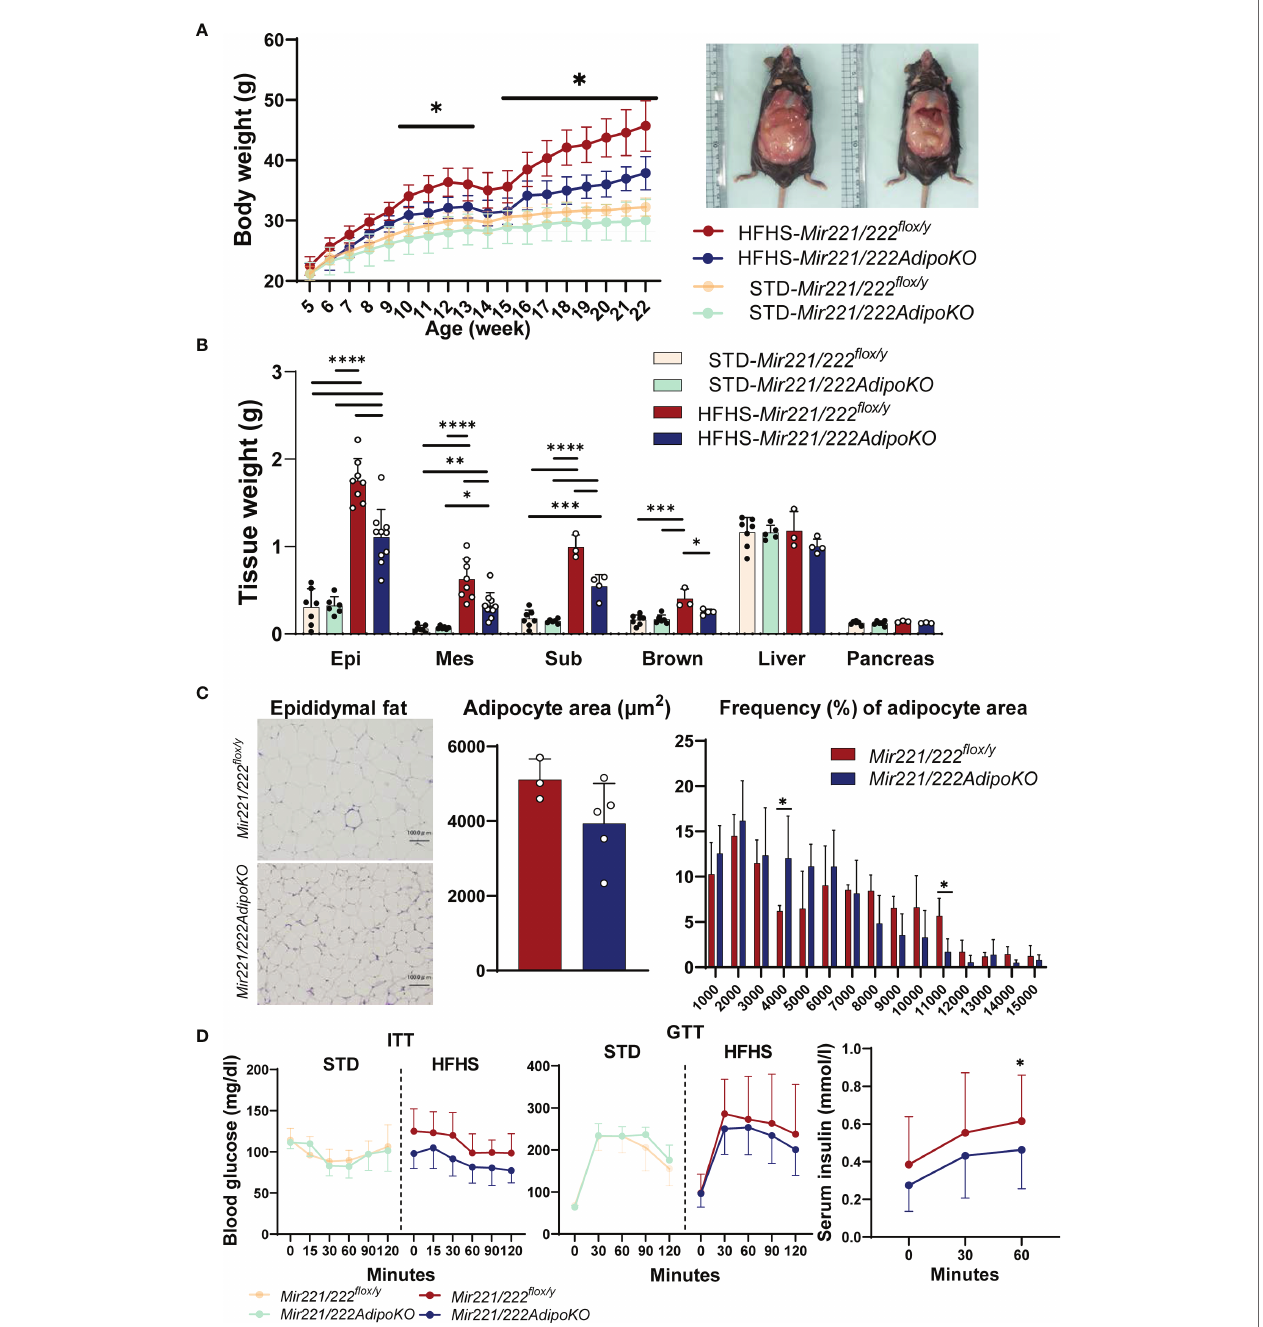
FIGURE 1 | The metabolic phenotypes of Mir221/222 fl ox/y and Mir221/222AdipoKO male mice fed with high fat high sucrose (HFHS) or standard (STD) chow. (A) Body weight of Mir221/222 fl ox/y and Mir221/222AdipoKO mice fed with HFHS (n=7) or STD chow (n=6), respectively. (B) Tissue weight of Mir221/222 fl ox/y and Mir221/222AdipoKO mice fed with HFHS or STD chow at 24 weeks of age. (Epi, epididymal; Mes, mesenteric; Sub, inguinal; Brown, Brown adipose tissues) (C) Adipocyte area in epididymal adipose tissues of Mir221/222 fl ox/y (n=3) and Mir221/222AdipoKO (n=5) mice fed with HFHS or STD. Quantitative analyses were carried out on PAS-stained paraf fi n sections. (D) Insulin tolerance test (ITT) in Mir221/222 fl ox/y (n=7) and Mir221/222AdipoKO (n=6). Glucose tolerance test (GTT) in Mir221/222 fl ox/y fed with HFHS (n=13) or STD chow (n=7) and Mir221/222AdipoKO fed with HFHS (n=16) or STD chow (n=6). Data shown as mean ± SD and analyzed by one-way ANOVA with Tukey test in (A, B) , and Mann-Whitney ’ s U test in (C, D) (*p<0.05; **p<0.01; ***p<0.001;